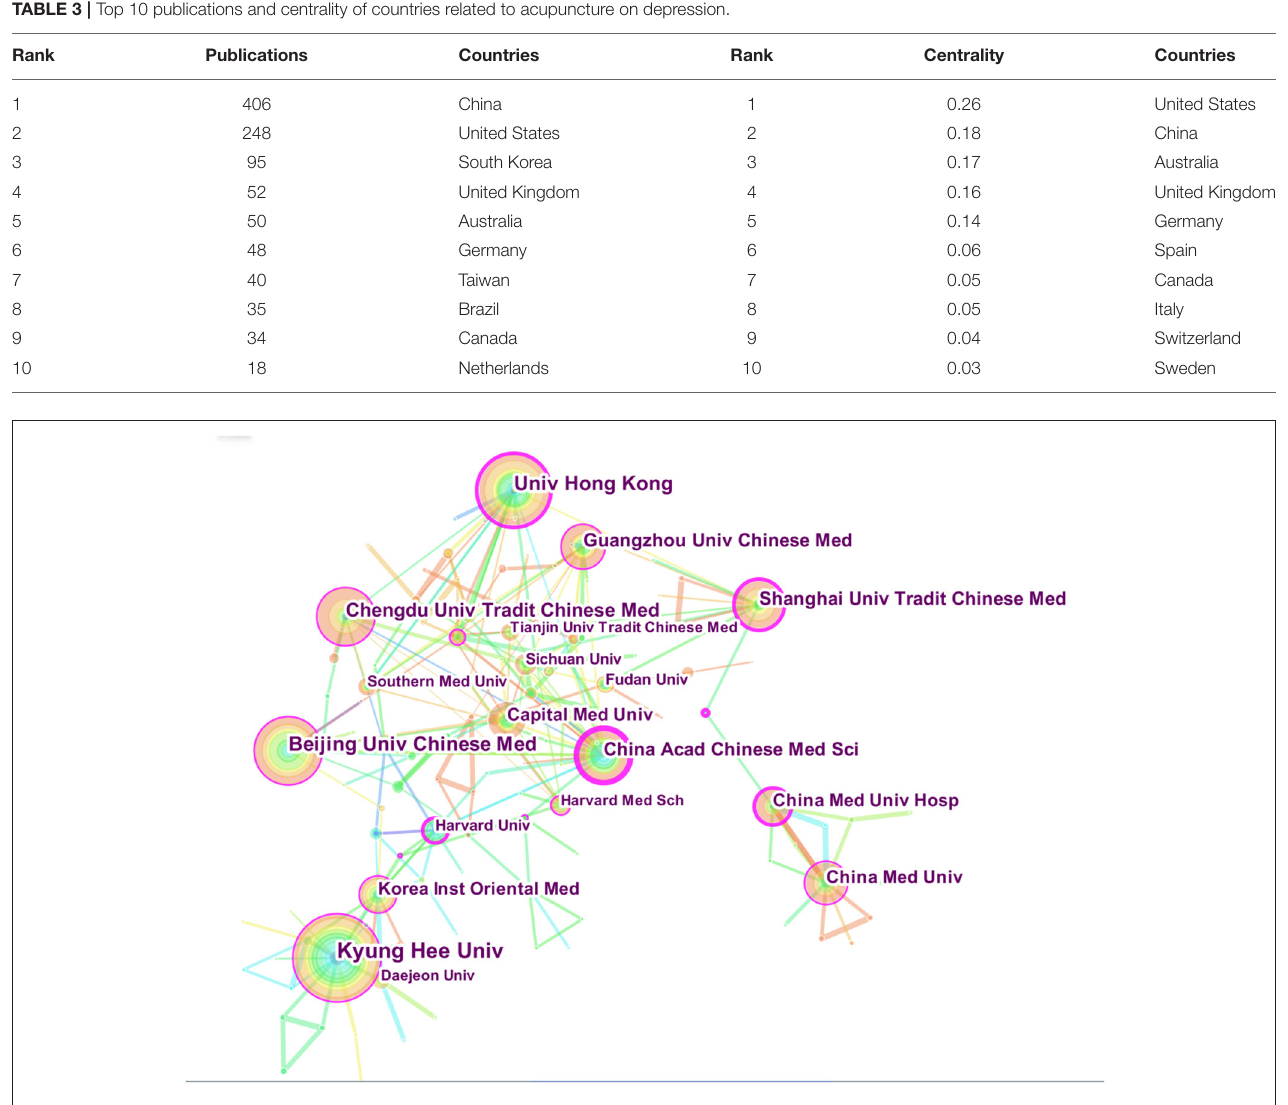
FIGURE 4 | Map of institutions researching acupuncture for depression from 2011 to